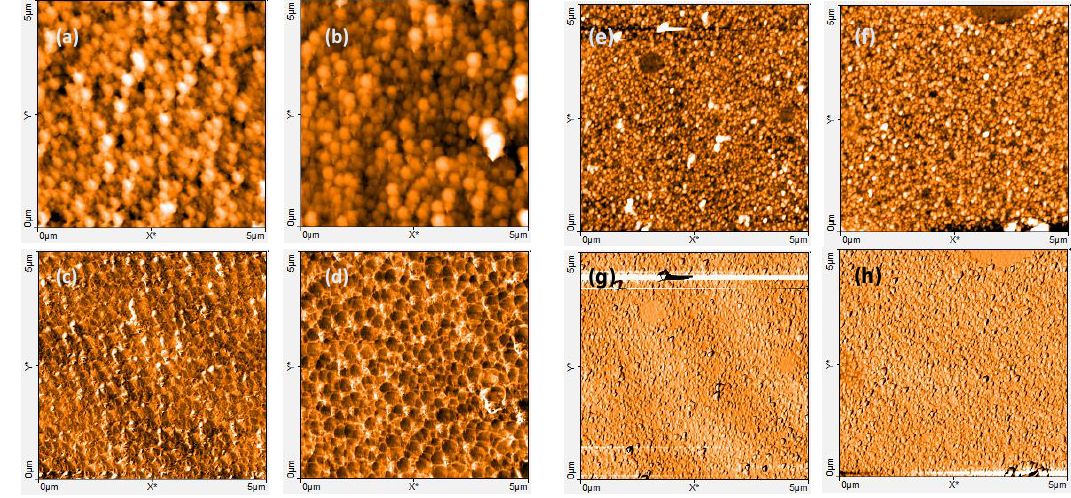
Figure 3. AFM images (5 × 5 µm ) of MIP ( a – d ) and NIP ( e – h ), before ( a , c , e , g ) and after ( b , d , f , h ) immersion in the protic solution. Topographic mode (top) and phase contrast mode (bottom).